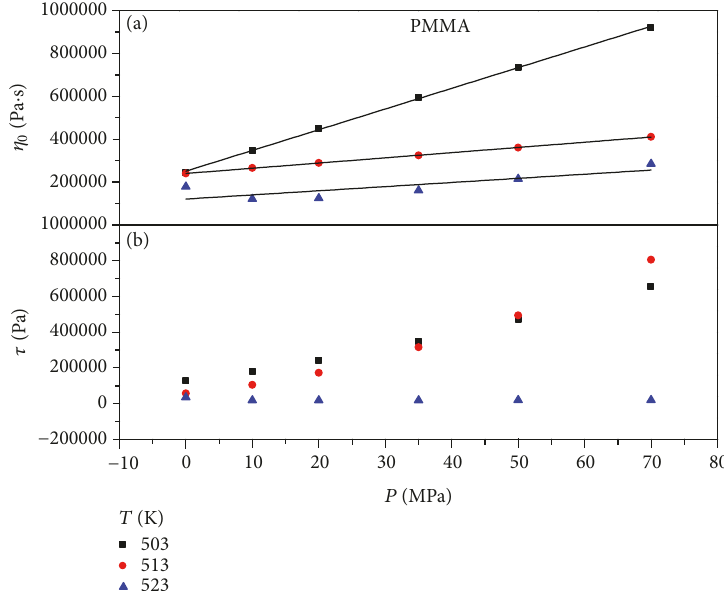
Figure 3: Zero level of elongational viscosities, 𝜂 0 , and critical stress parameter, 𝜏 , computed by (5), with respect to pressures for PMMA at different temperatures. Solid lines represent linear fitting through the data